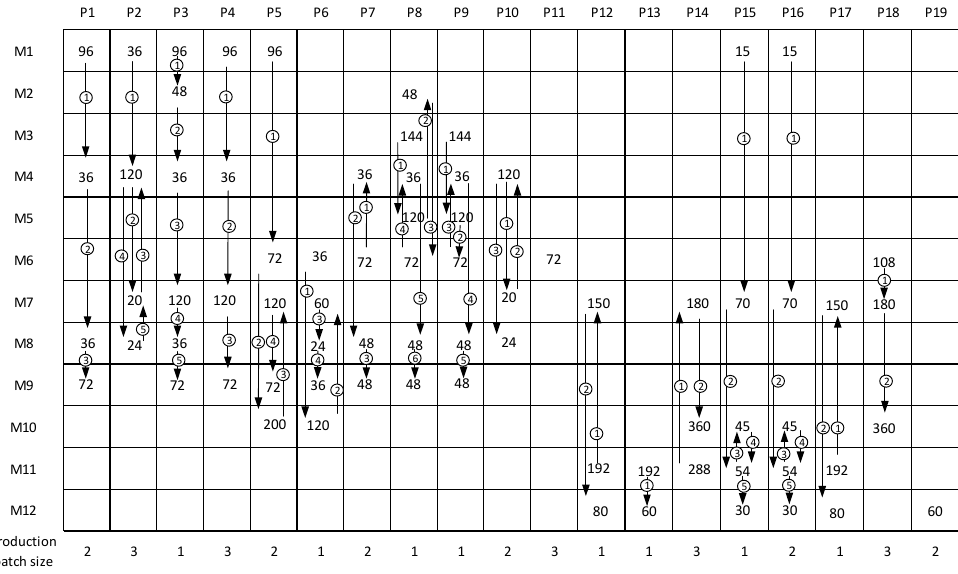
Figure 4. Sequences of machines for each job/part.